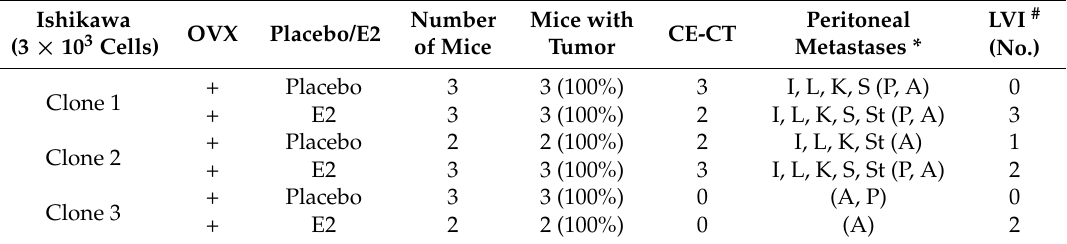
Table 2. Overview of the experimental animals used to develop the E2-dependent endometrial cancer